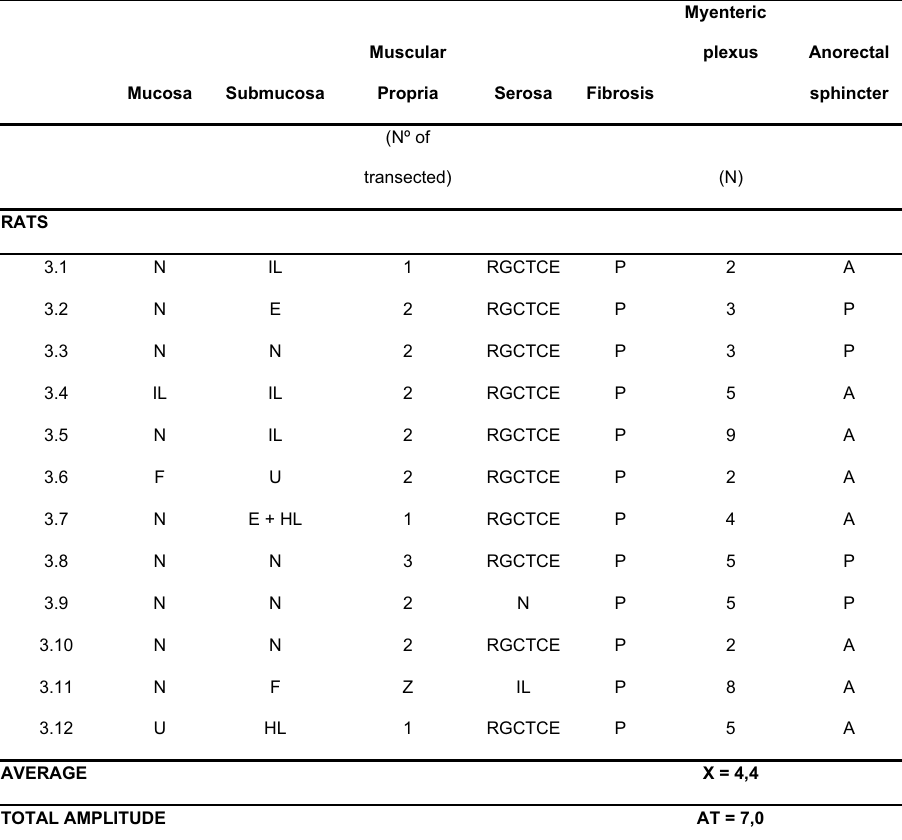
TABLE 3 – Histology of Intestinal Segments – RATS G3